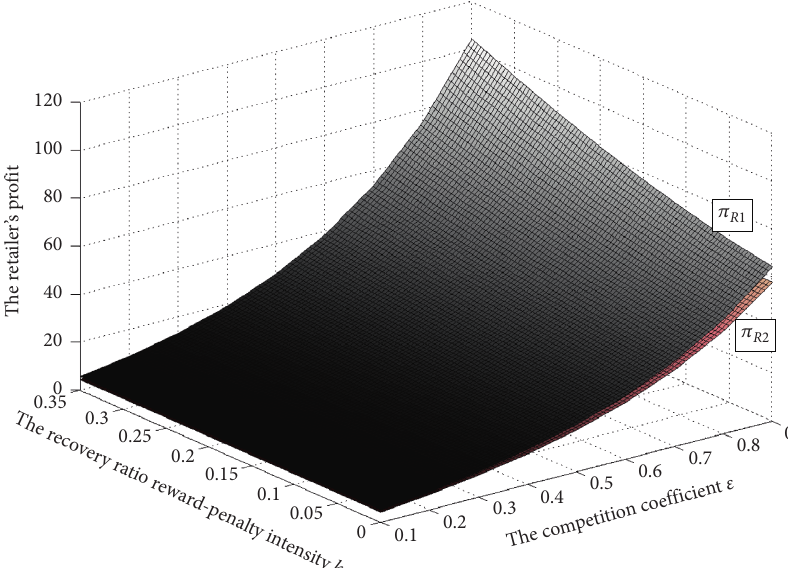
Figure 10: The retailer’s profit π